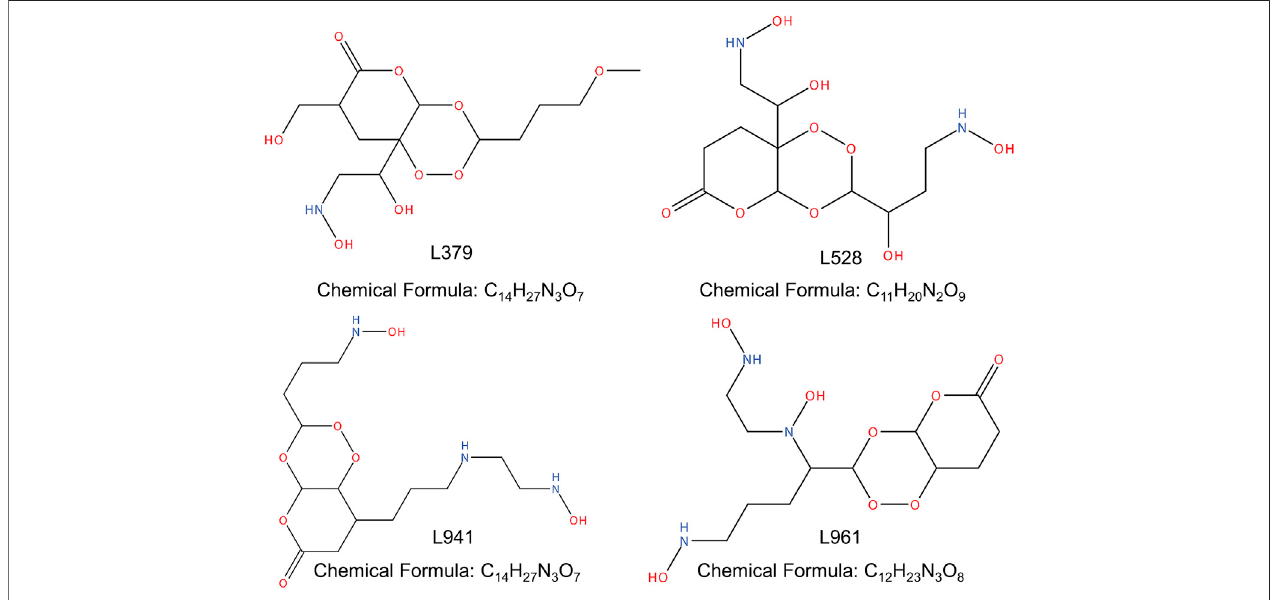
FIGURE 3 | Selected de novo designed GALNT2 candidate